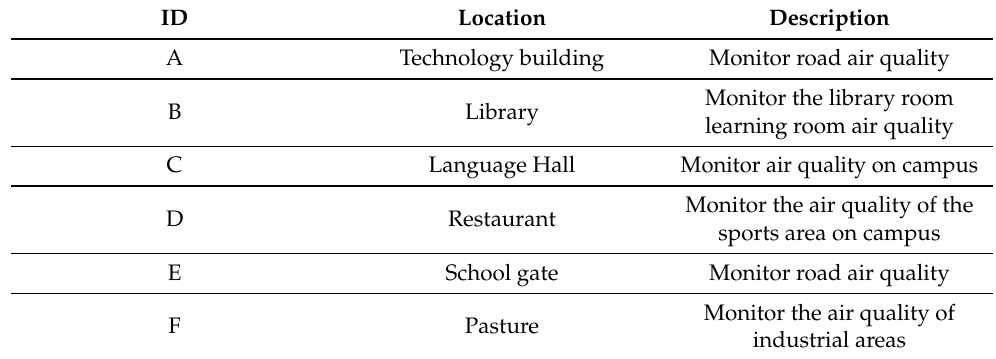
Table 3. The locations of monitoring